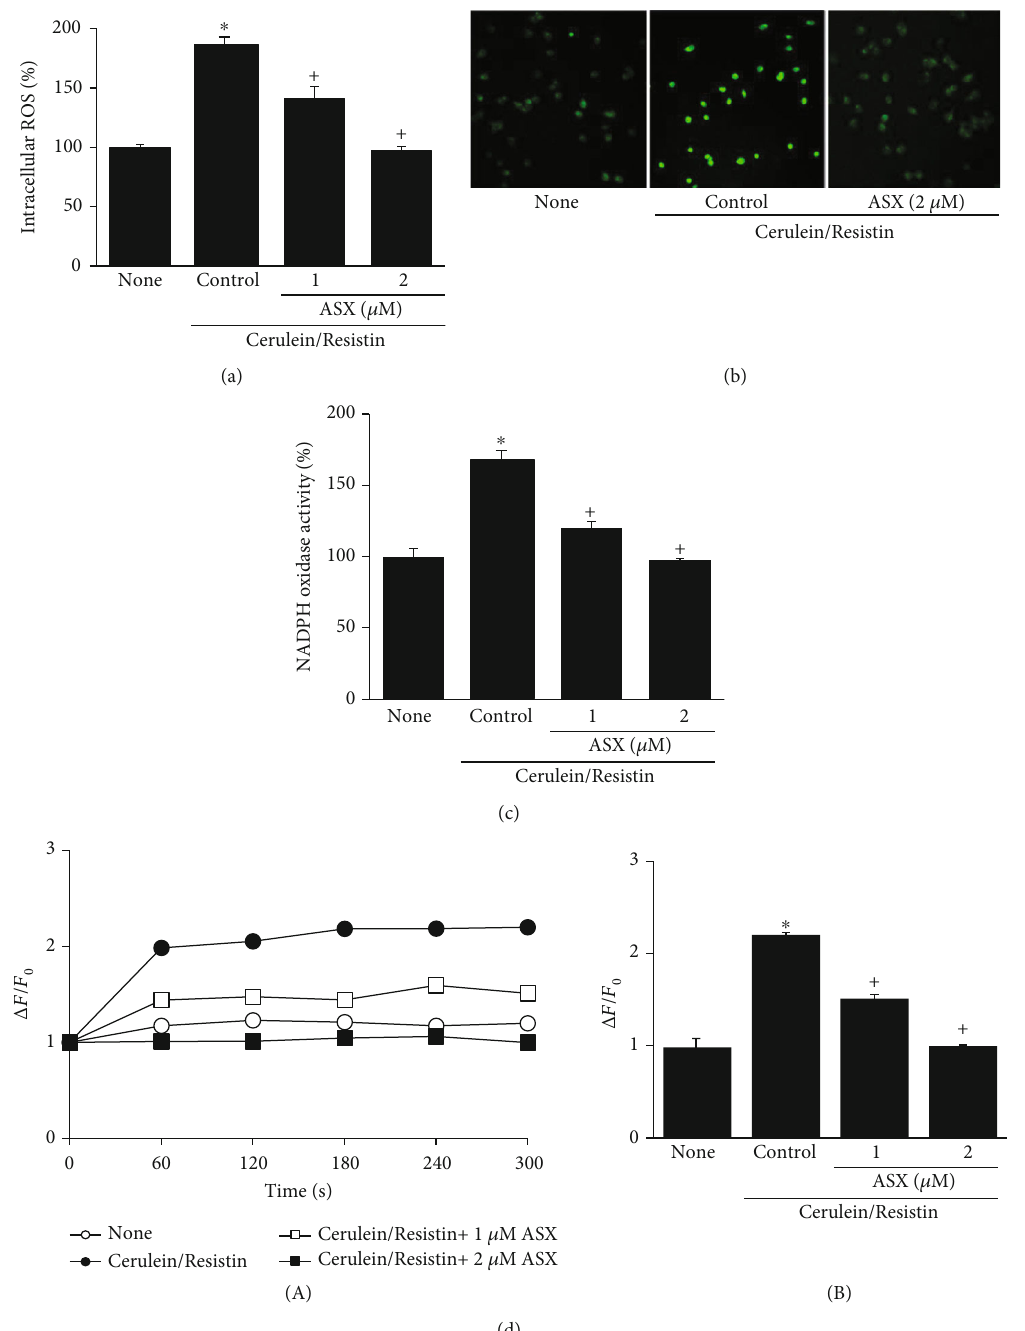
Figure 4: Astaxanthin (ASX) inhibits cerulein/resistin-induced increases in ROS, NADPH oxidase activity, and Ca 2+ level in AR42J cells. The cells were pretreated with the indicated concentrations of ASX for 3h and then stimulated with cerulein/resistin for 45 min (for ROS levels, ROS fl uorescence imaging, and NADPH oxidase activity (a – c)), and for the indicated period (for Ca 2+ level (d)). (a) Intracellular ROS levels were measured by dichloro fl uorescein diacetate (DCF-DA) fl uorescence. (b) Representative images of ROS-induced fl uorescence response of DCF-DA. (c) NADPH oxidase activity was measured by the lucigenin assay. (d) Ca 2+ level was determined by measuring the fl uorescence changes of fl uo-4 AM at excitation and emission wavelengths of 494nm and 525 nm, respectively. Ca 2+ levels were expressed as Δ F / F 0 , where F 0 is the resting background fl uorescence, and Δ F is fl uorescence change over time after treatment with cerulein/resistin in the presence or absence of ASX. Fluorescence transient changes (obtained within 1-5 min) were plotted (A). (B) Ca 2+ levels were expressed as Δ F / F mean ± S : E : of three di ff erent experiments. ROS level, NADPH oxidase activity, and Ca 2+ 0 of the cells. Data are expressed as the level in none (untreated cell) were set as 100 (a, c) or 1 (d). ∗ p < 0 : 05 vs. none (untreated cells); + p < 0 : 05 vs. cerulein (cells treated with cerulein